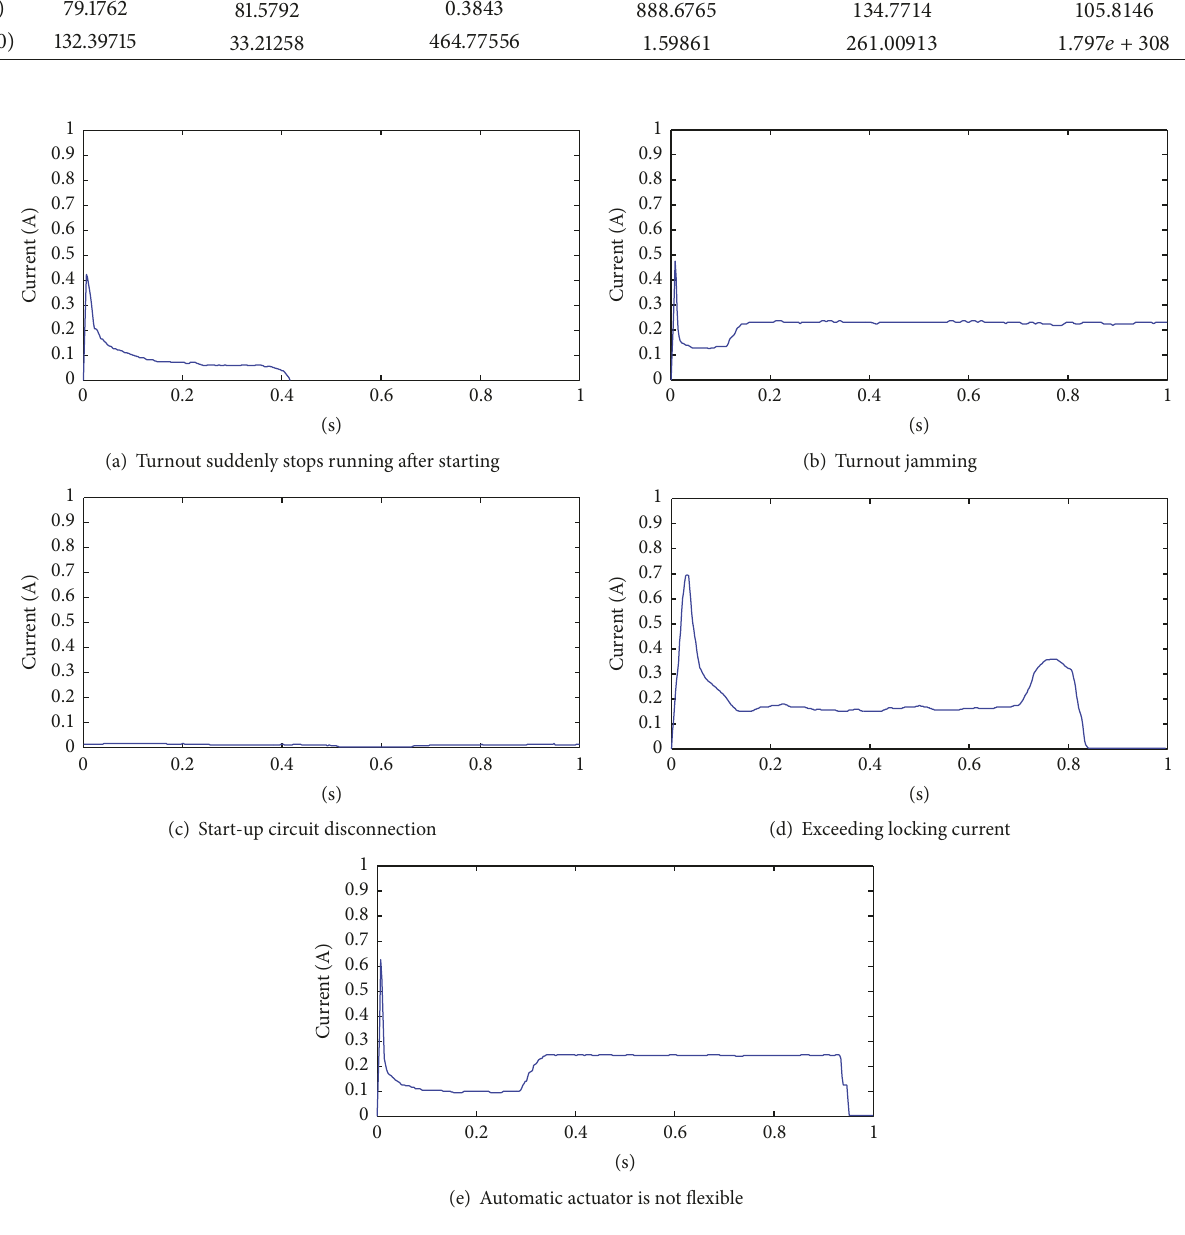
Figure 6: Turnout fault current